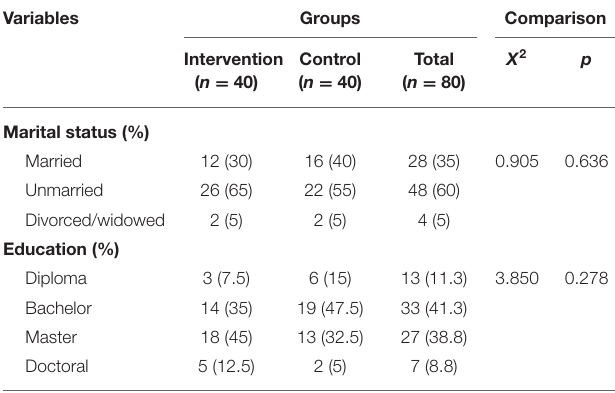
TABLE 5 | The comparison of demographic data between control and intervention groups. Variables